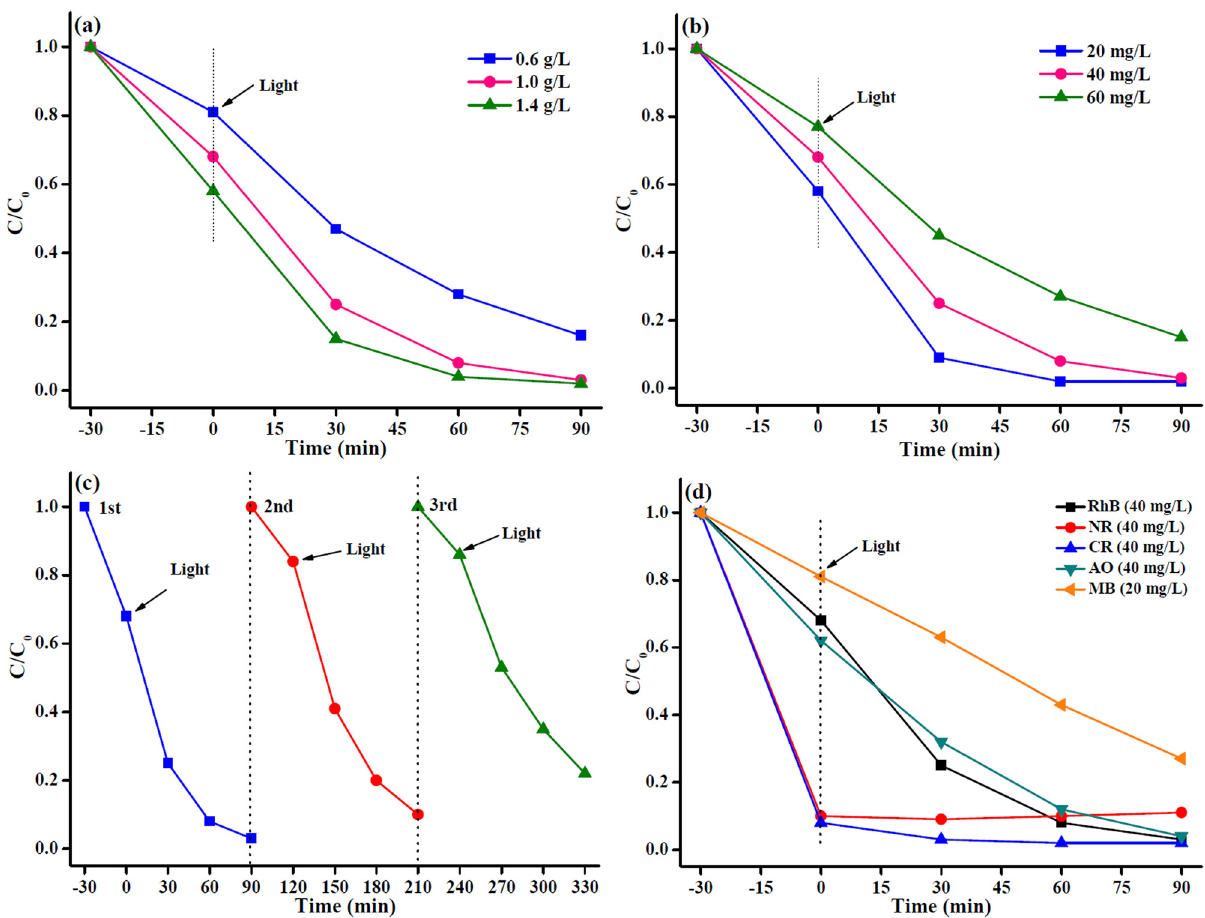
Figure 7: ( a ) Photocatalytic degradation of RhB with various dosages of Bi 2 O 3 @Zn - MOF - 2 catalyst. ( b ) Photocatalytic degradation of RhB with di ff erent concentrations using Bi 2 O 3 @Zn - MOF - 2 catalyst. ( c ) Cyclic stability of Bi 2 O 3 @Zn - MOF - 2 catalyst after three cycles. ( d ) Photocatalytic degradation of various organic dyes using Bi - MOF - 2 2 O 3 @Zn